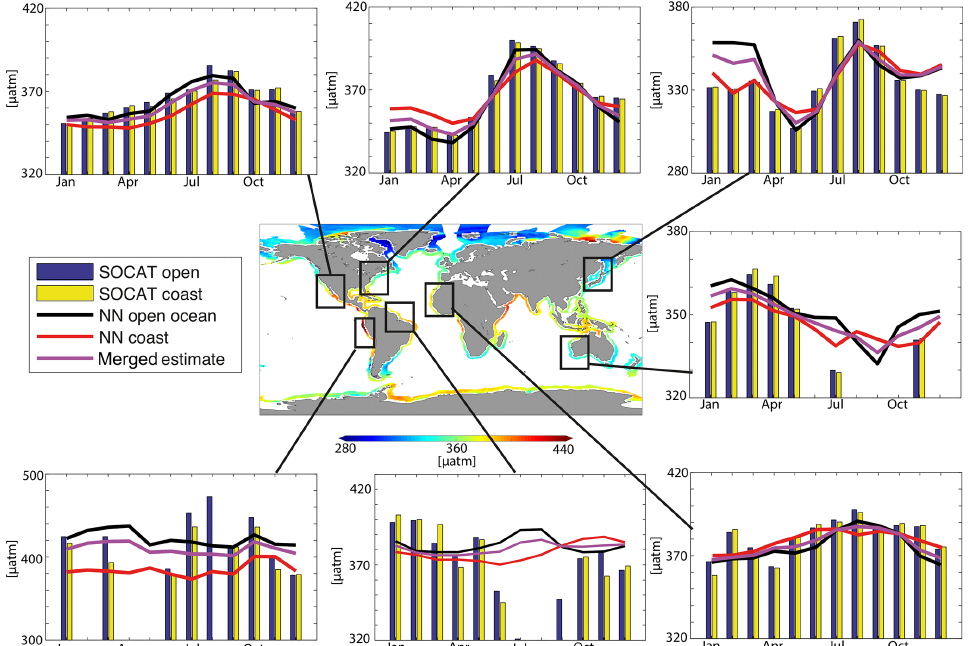
Figure 14. Seasonal p CO 2 cycle for the seven regions discussed in the text and highlighted in the center map. The seasonal cycles include a comparison of the monthly mean SOCAT observations without any interpolation (blue and yellow bars) as well as the open-ocean (blue line), coastal-ocean (red line) and merged (magenta line) reconstructions based on the respective SOCAT